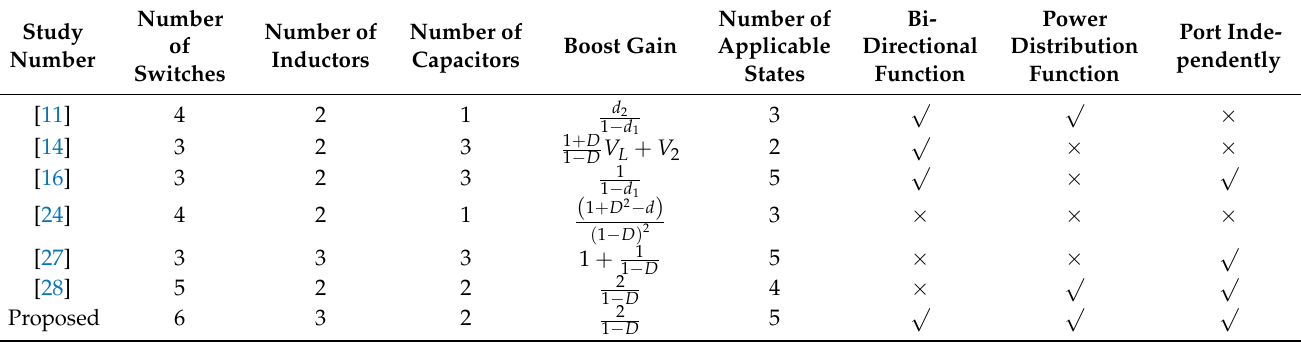
Table 1. Comparison of the proposed integrated converter topology with other on-board converters.